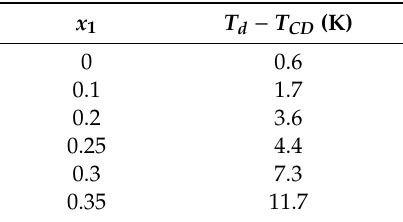
for DMSO–water dT df for dT